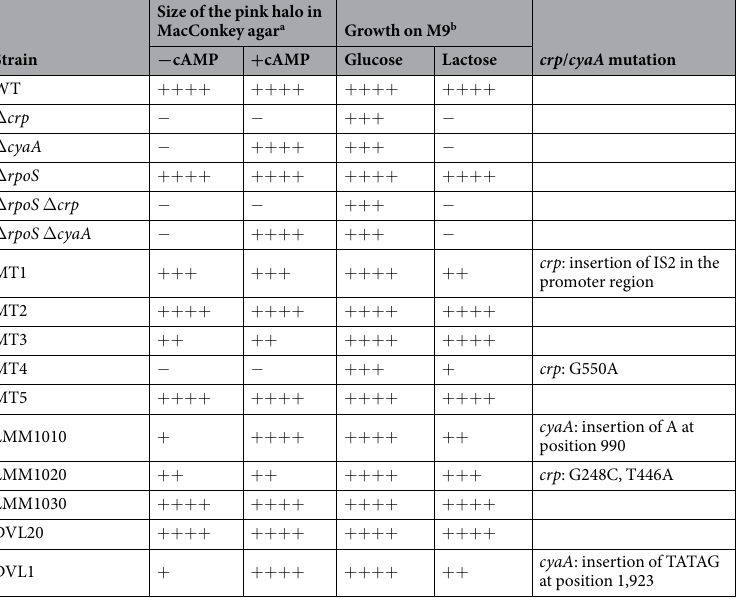
Table 1. Phenotypic characterization of E. coli MG1655 WT and its indicated mutants on MacConkey lactose agar with or without 5 mM of cAMP added, and on M9 glucose or lactose agar. The corresponding mutations found in the crp or cyaA sequence (if any) are indicated. a The size of the pink halo formed by 20 µ l of stationary phase cultures diluted 1/100 in 0.85% KCl after overnight incubation was scored from − (no halo) to ++++ with respect to the Δ crp and Δ cyaA mutants and the WT and ∆ rpoS parent, respectively (Supplementary Fig. S1). b The growth of 5 µ l of stationary phase cultures diluted 1/100 in M9 salts after 48 h of incubation was scored from − (no growth) to ++++ with respect to the Δ crp and Δ cyaA mutants and the WT and ∆ rpoS parent, respectively.